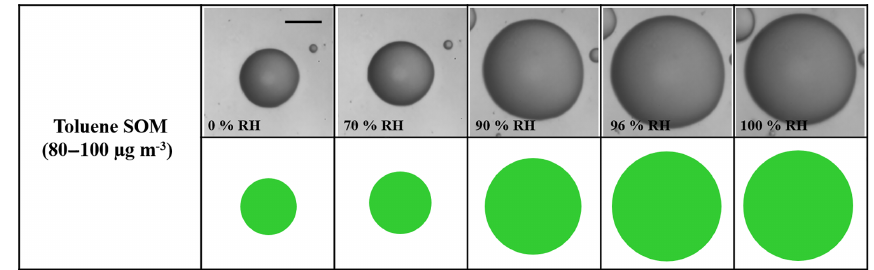
Figure 3. Optical images of toluene-derived SOM for the particle mass concentrations of 80–100µgm − 3 (toluene 2, Table 2) with increasing RH. Illustrations of the images are shown for clarity. Green: SOM-rich phase. Size bar is